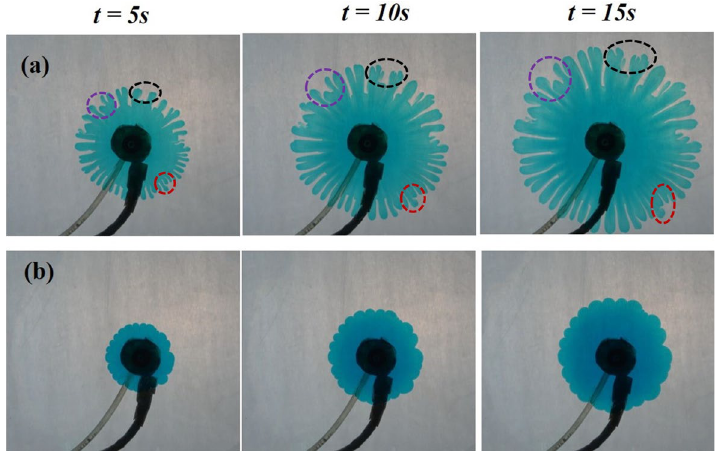
Figure 1. Temporal evolution of the VF dynamics for M = 3, Q = 0.1 mL/s and b = ( a ) 0.3 mm, ( b ) 0.8 mm. An example of tip-splitting, merging and shielding is marked respectively with a black, red and purple circle/ ellipse.